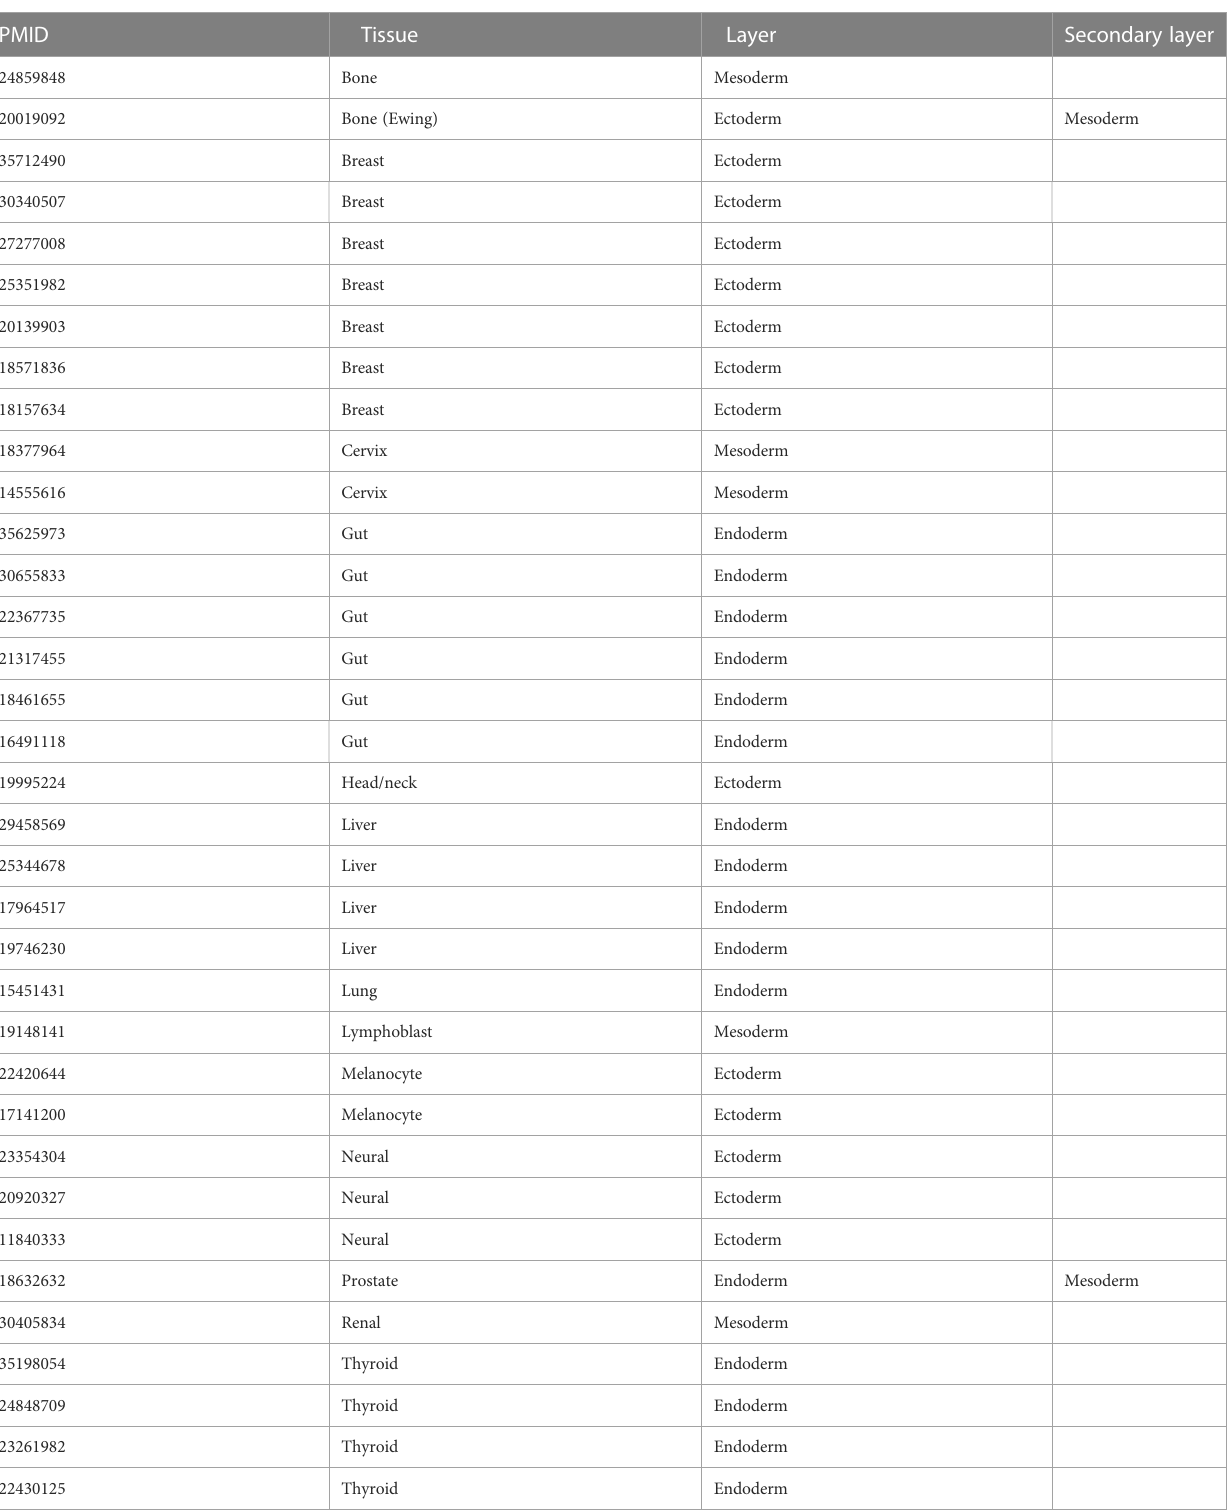
TABLE 2 List of studies where Dkk-1 is a reported as a tumor